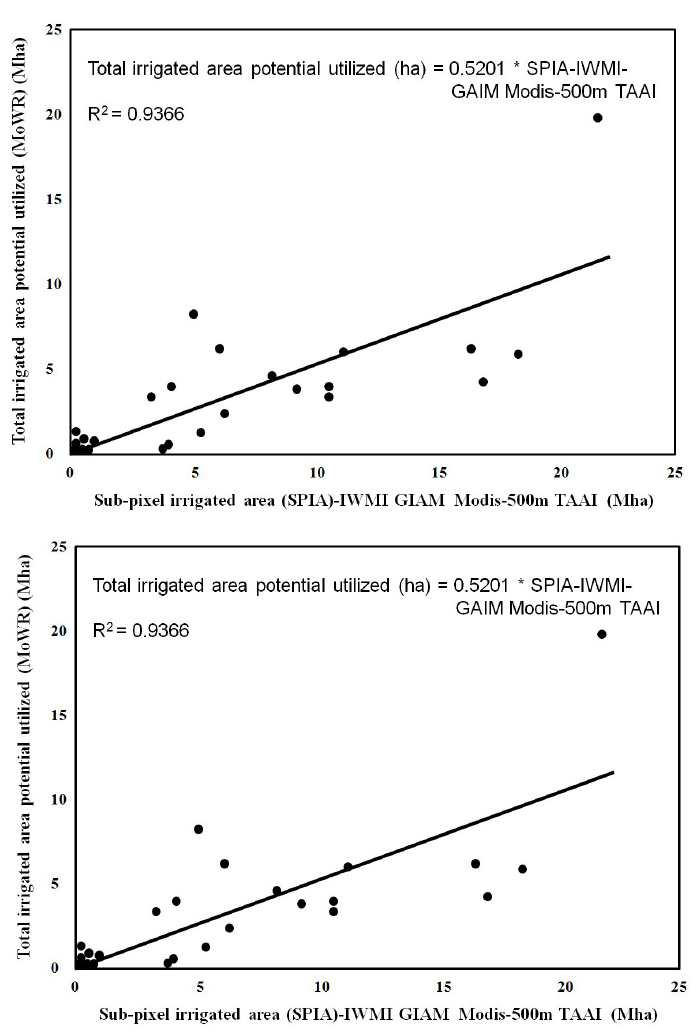
Figure 8. Actual irrigated areas from the Ministry of Water Resources (MoWR) are plotted